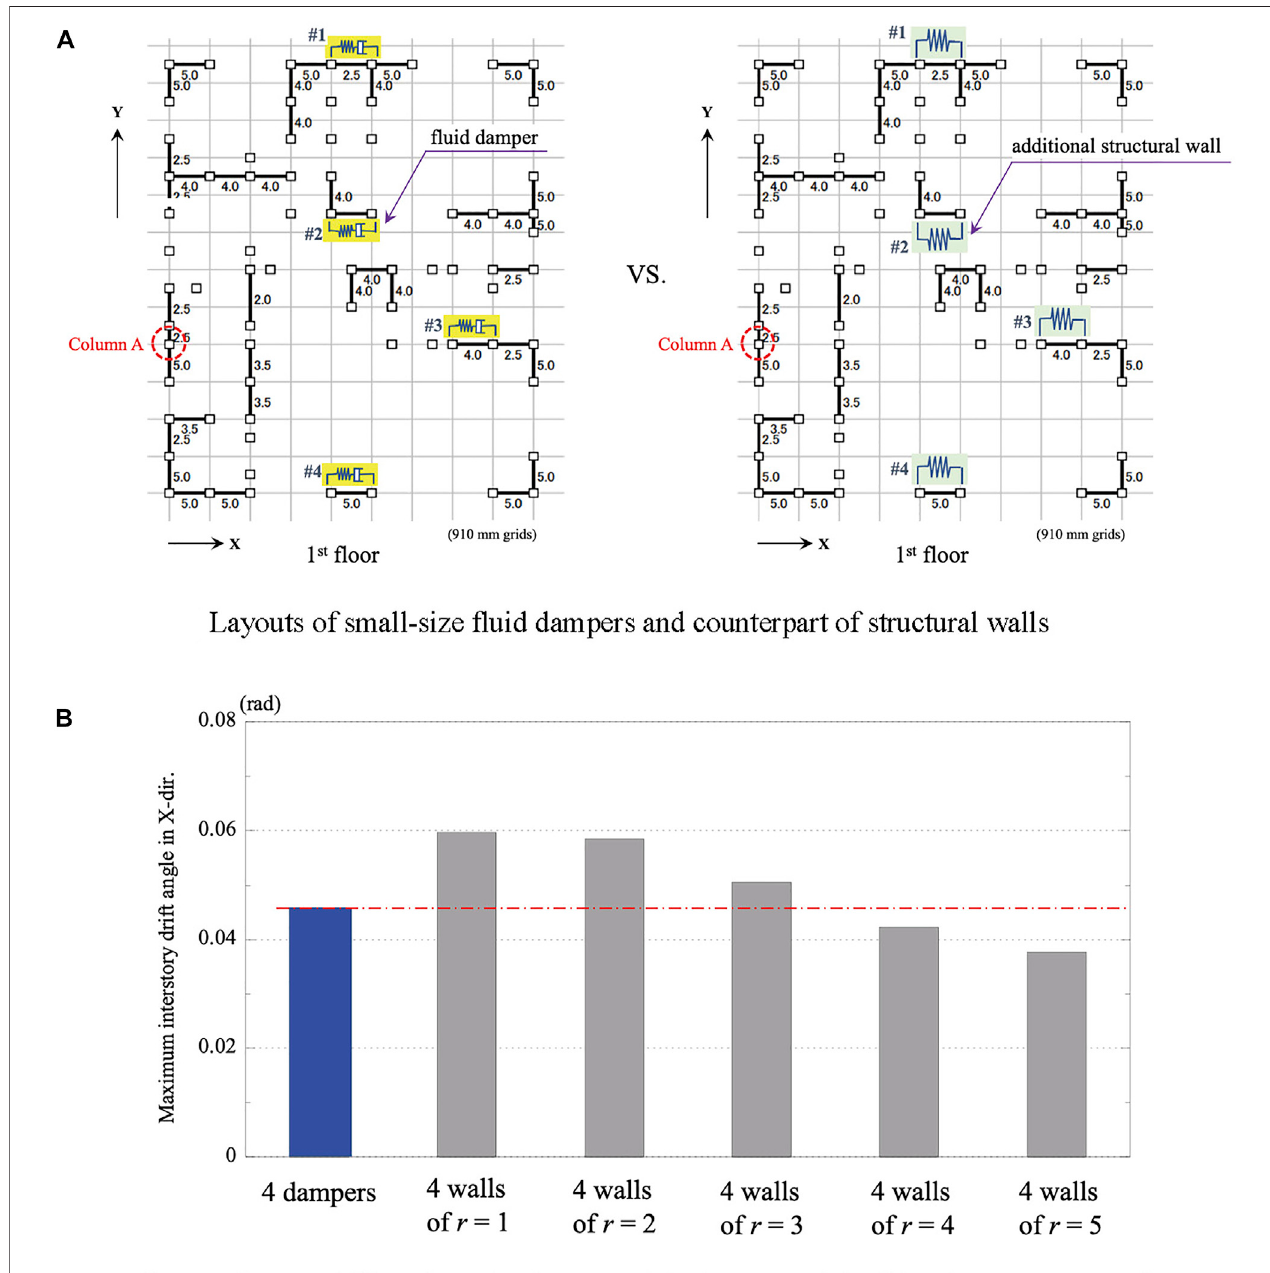
FIGURE 14 | Comparative response analyses between small-size fl uid dampers and conventional structural walls. (A) Layouts of small-size fl uid dampers and counterpart of structural walls. (B) Maximum 1st-story drift angles of column A of the house model with 4 dampers or 4 walls.